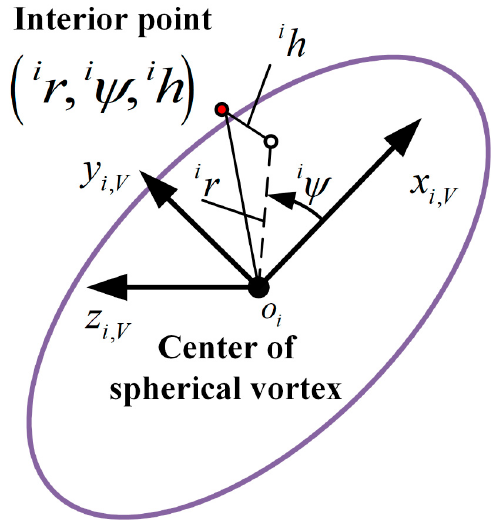
Figure 3. Schematic diagram of ellipsoidal vortex coordinate system.